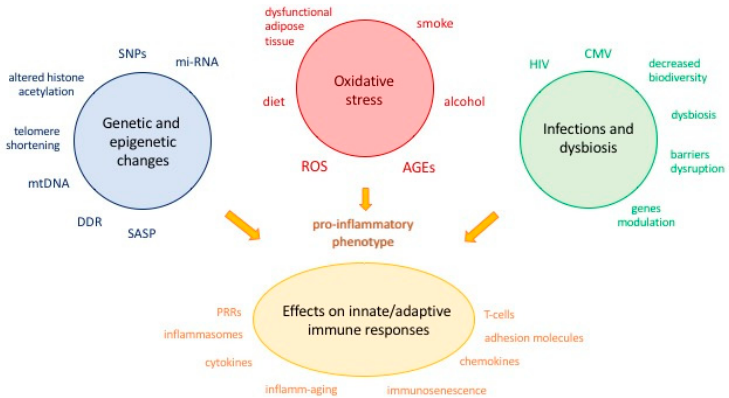
Figure 1. Genetic and environmental factors contributing to changes in the innate and adaptive immune response with age. AGEs: advanced glycation end products; CMV: cytomegalovirus; DDR: DNA damage response; HIV: human immunodeficiency virus; mi-RNA: microRNA; mtDNA: mitochondrial DNA; PRRs: pattern recognition receptors; ROS: reactive oxygen species; SASP: senescence-associated secretory phenotype; SNPs: single nucleotide polymorphisms.